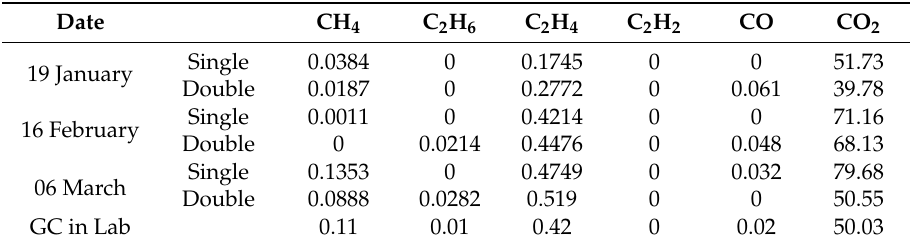
Table 4. Analysis results on-site